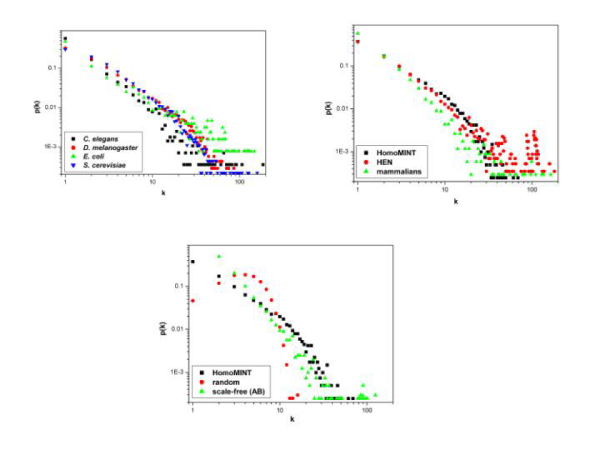
Degree distribition of the HomoMINT network compared with different biological networks. Frequency of nodes with k links for A) the model organism experimental networks in the MINT database B) the assembled Human experimental network (HEN), the Human inferred (HomoMINT) data set, the Mammalian data set in MINT and C), for a random network of similar size and for a scale-free network assembled according to Barabasi [31].